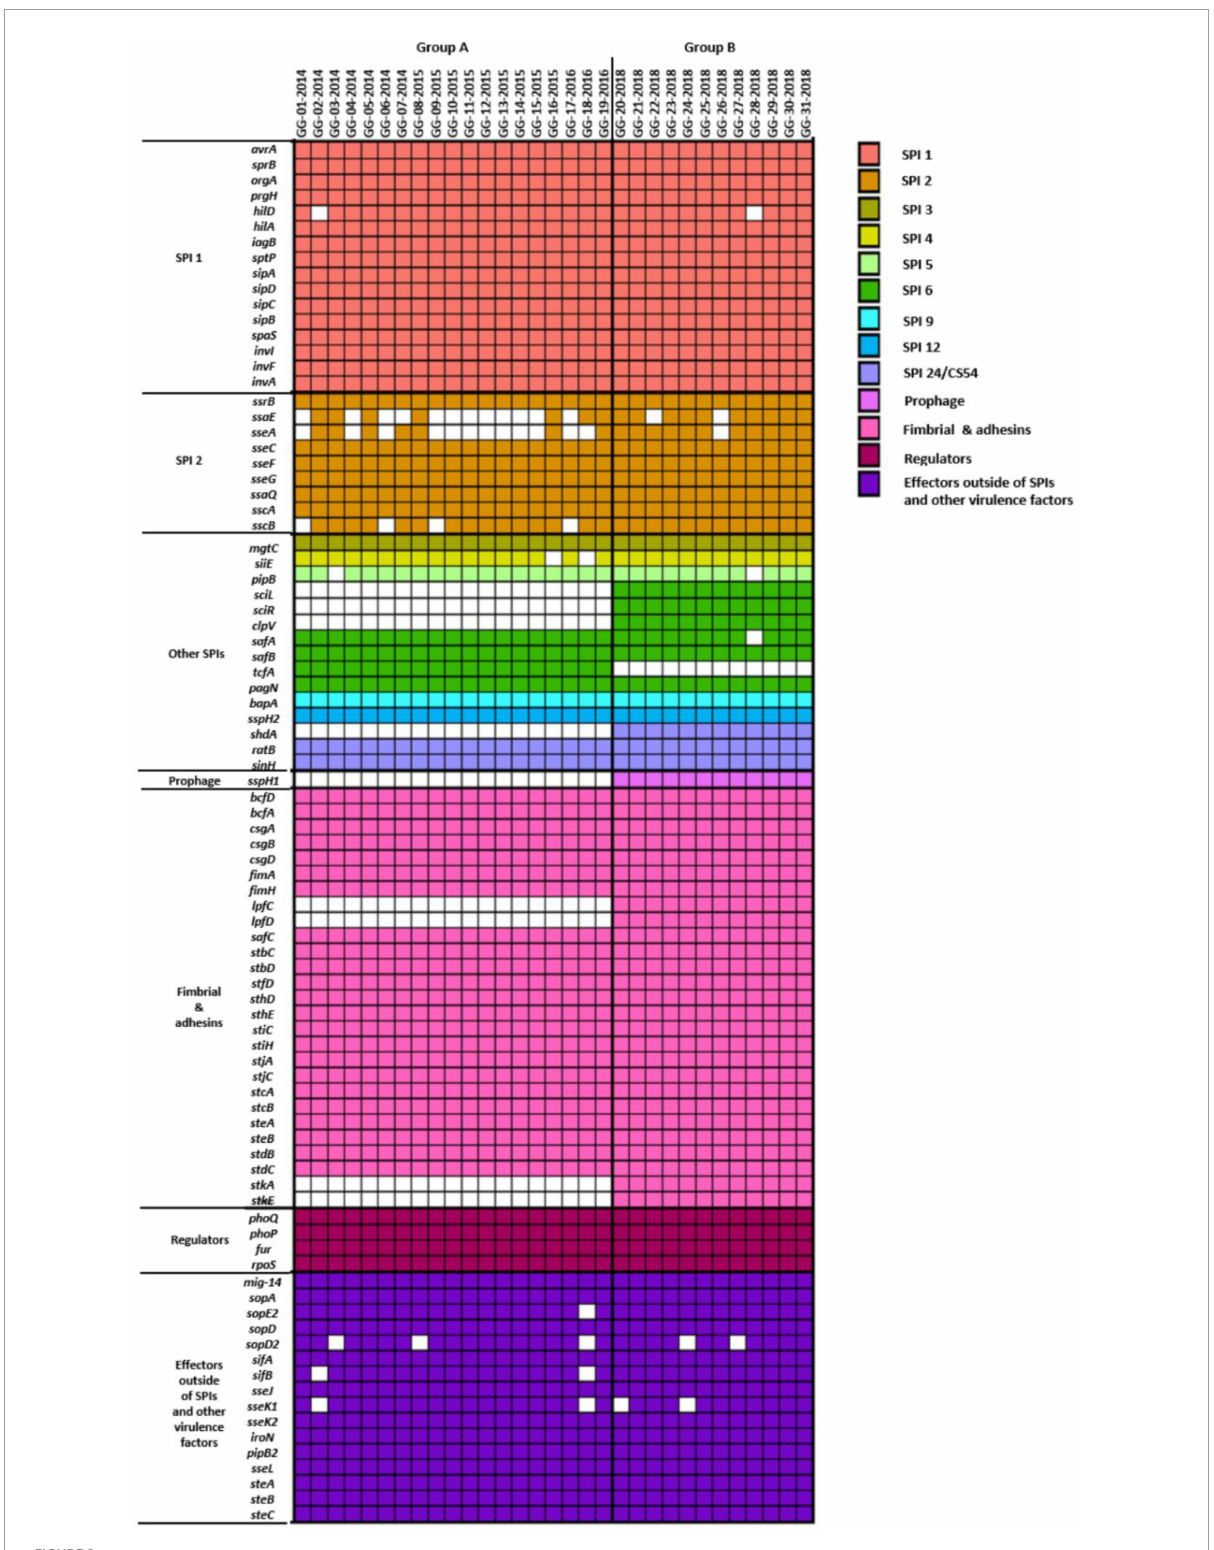
FIGURE2 Heatmap of virulence genes present in 31 S . Bareilly isolates. Rows represent virulence genes and columns show each S . Bareilly isolate. The left side of the figure represents the following categories of virulence genes: SPIs, prophage, fimbria and adhesins, regulators, and effectors outside of SPIs and other virulence